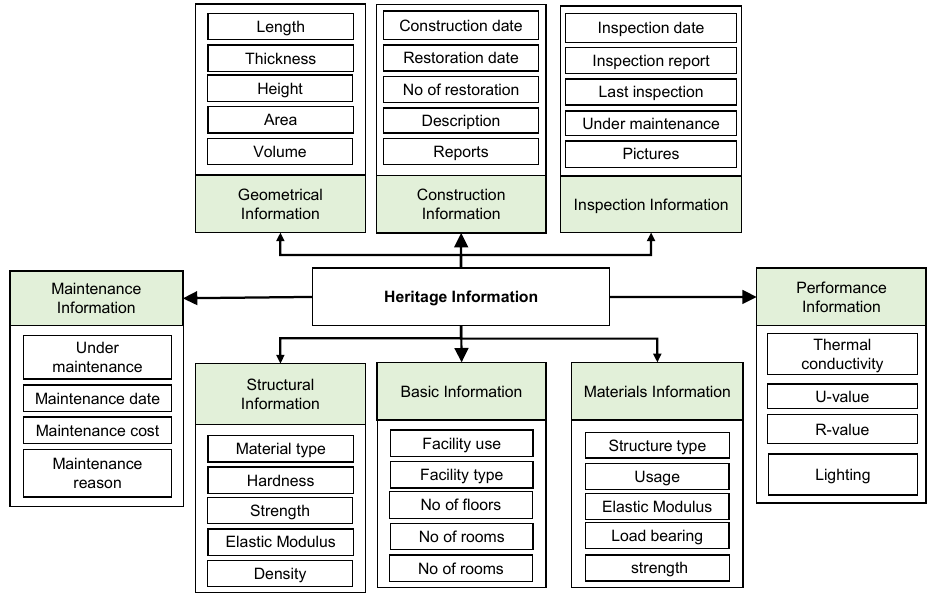
Figure 5. Categorization of the different domains of data required for the heritage management.